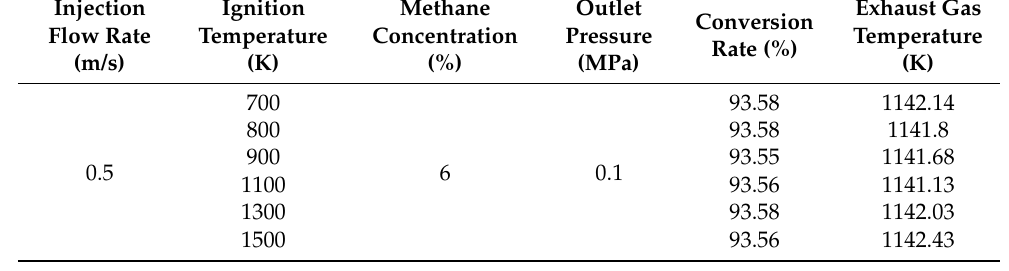
Table 3. Simulation parameters of the influence of ignition temperature on conversion rate and exhaust gas temperature.